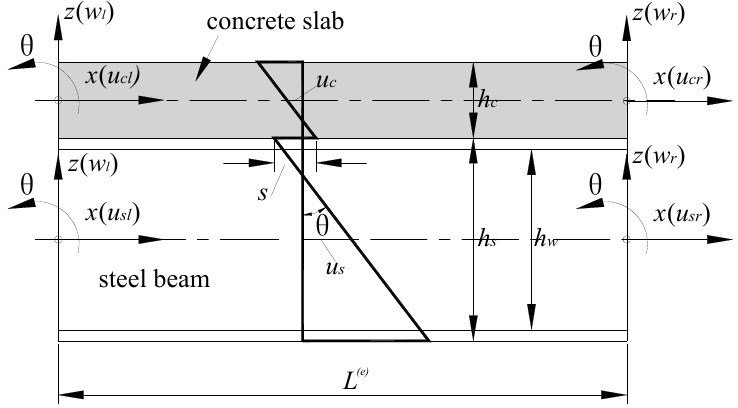
Figure 2. Displacement field of the composite beam element model.